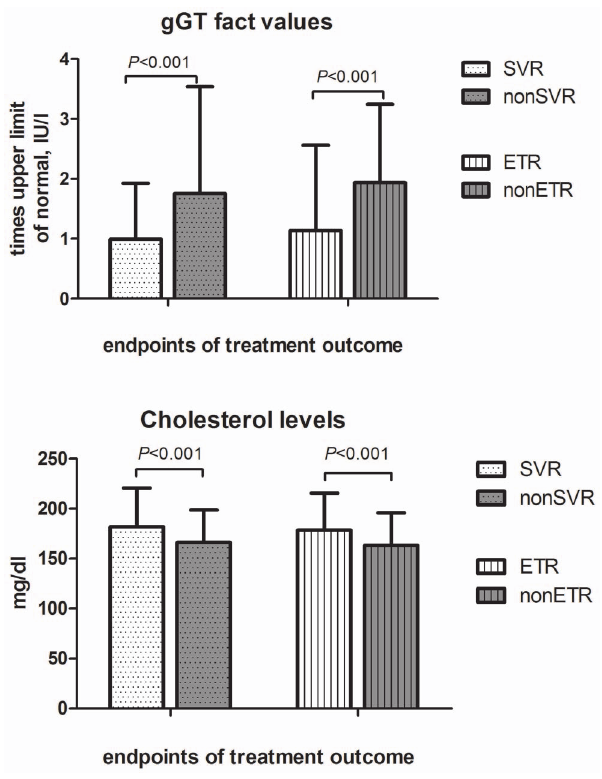
Figure 3. Variations of IP10-levels in patients with and without SVR at baseline, week 1 and 4 upon treatment initiation.